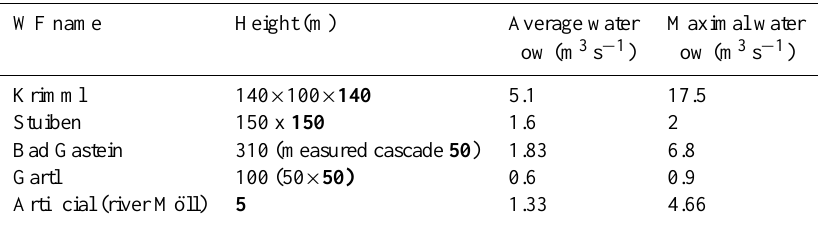
Table 1. Height of WF cascades (approximate), average and maximal water flow. Bold numbers represent the heights of the investigated cascades.